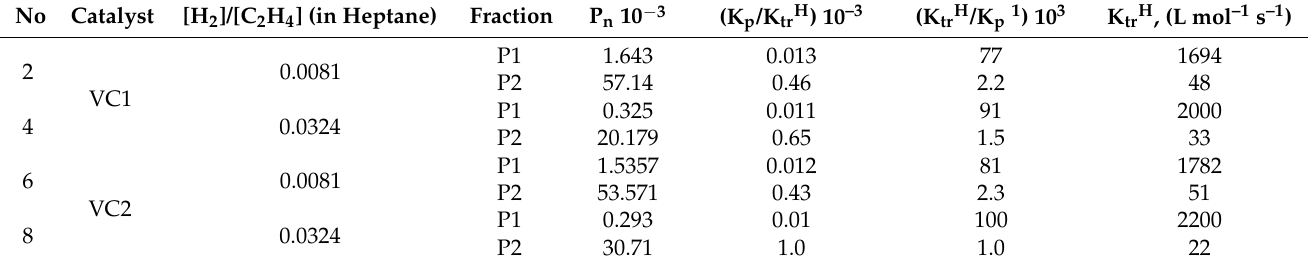
Table 3. Rate constants of polymer chain transfer with hydrogen during ethylene polymerization over the VC1 and VC2 catalysts, which were calculated for two groups of VMC active sites producing fractions P1 and